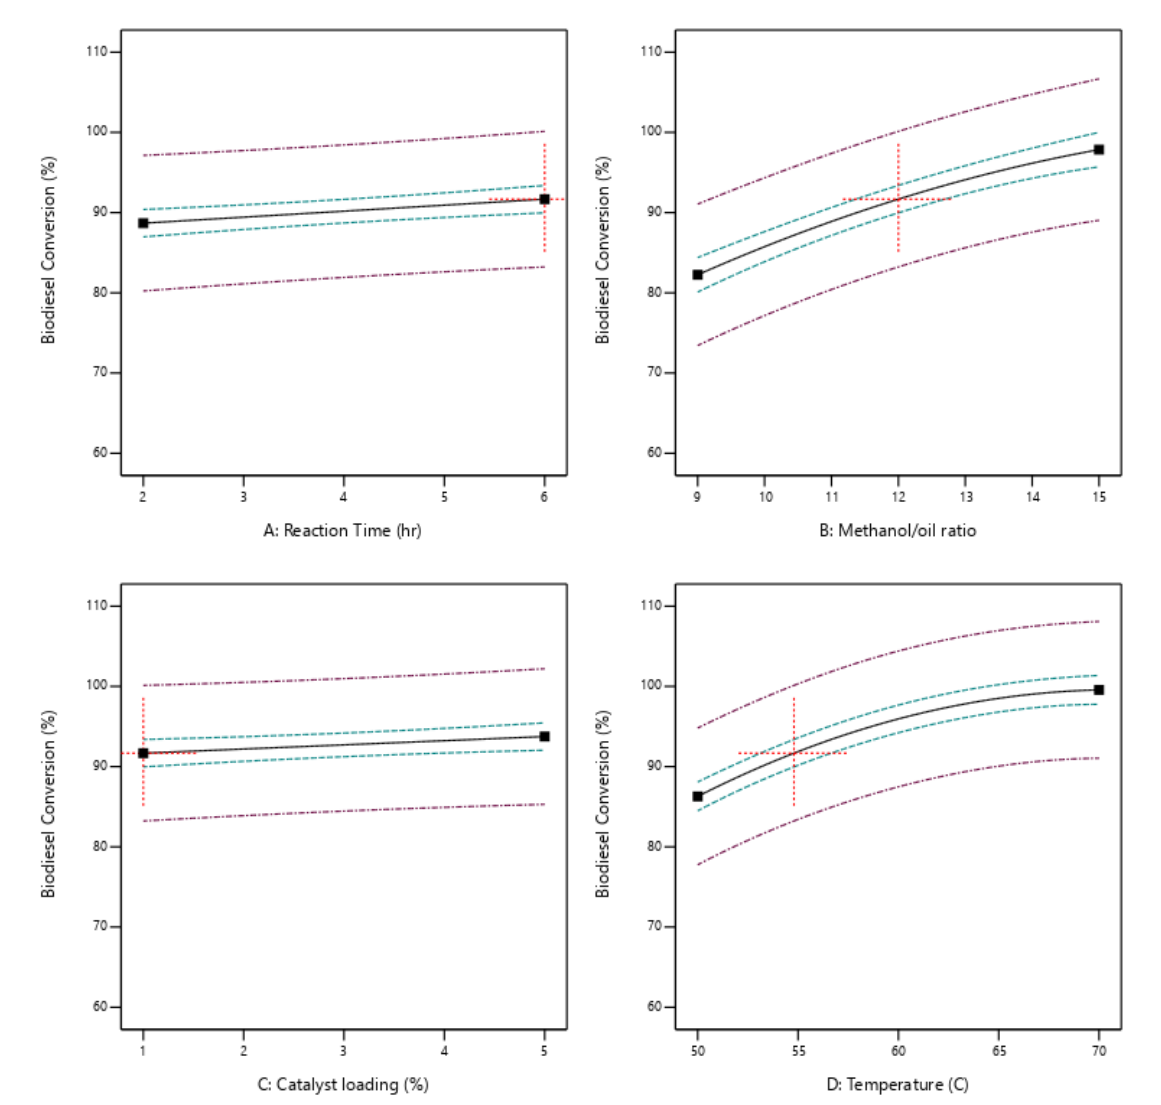
Figure 14. Process variables affect the yield of biodiesel .